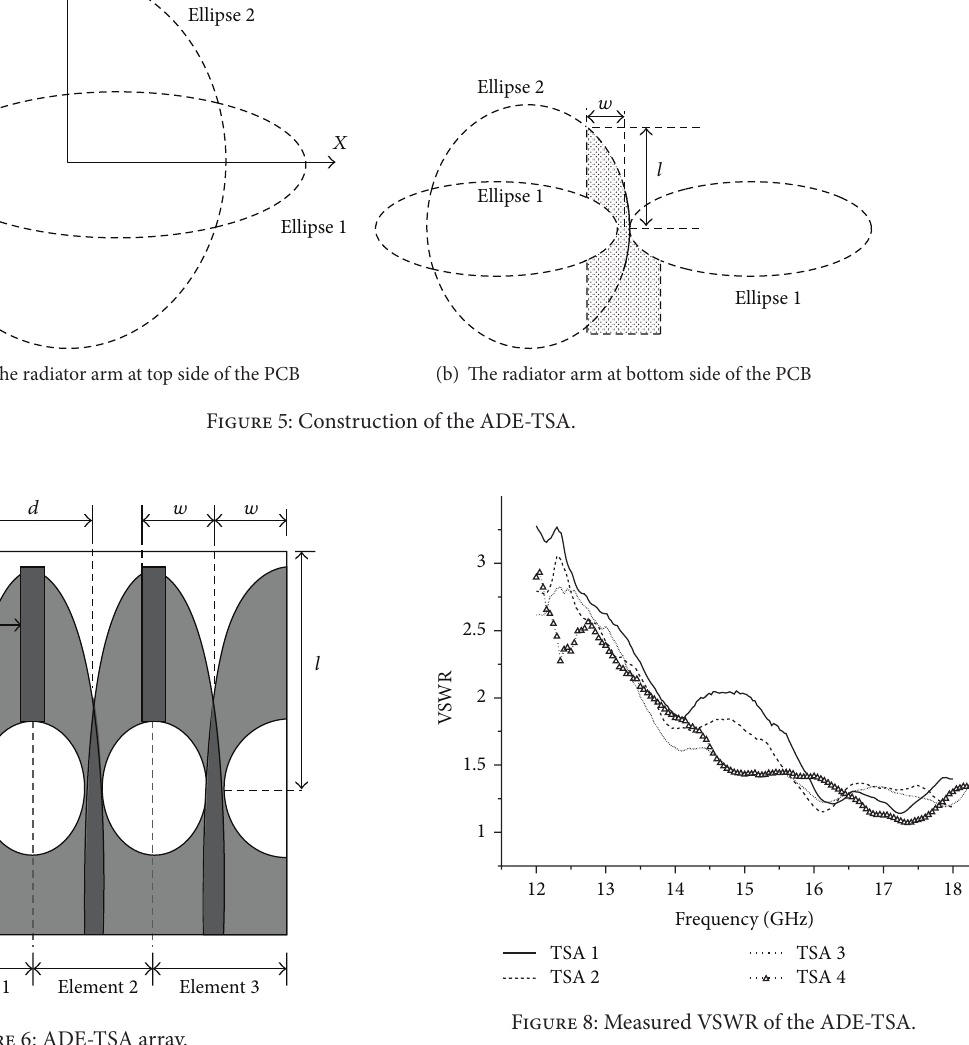
Figure 6: ADE-TSA array.